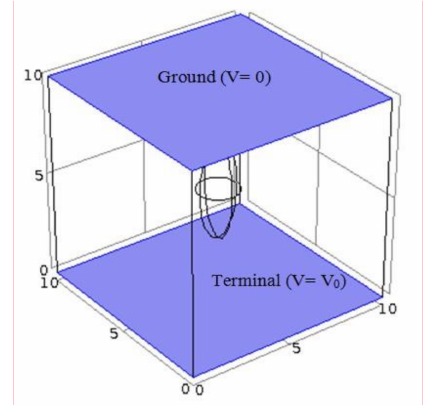
Figure 6. Terminal and ground boundary